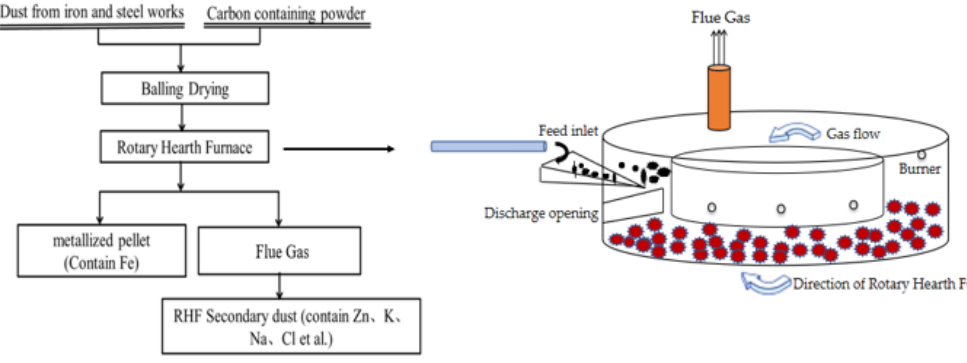
Figure 1. Process flow chart of RHF.